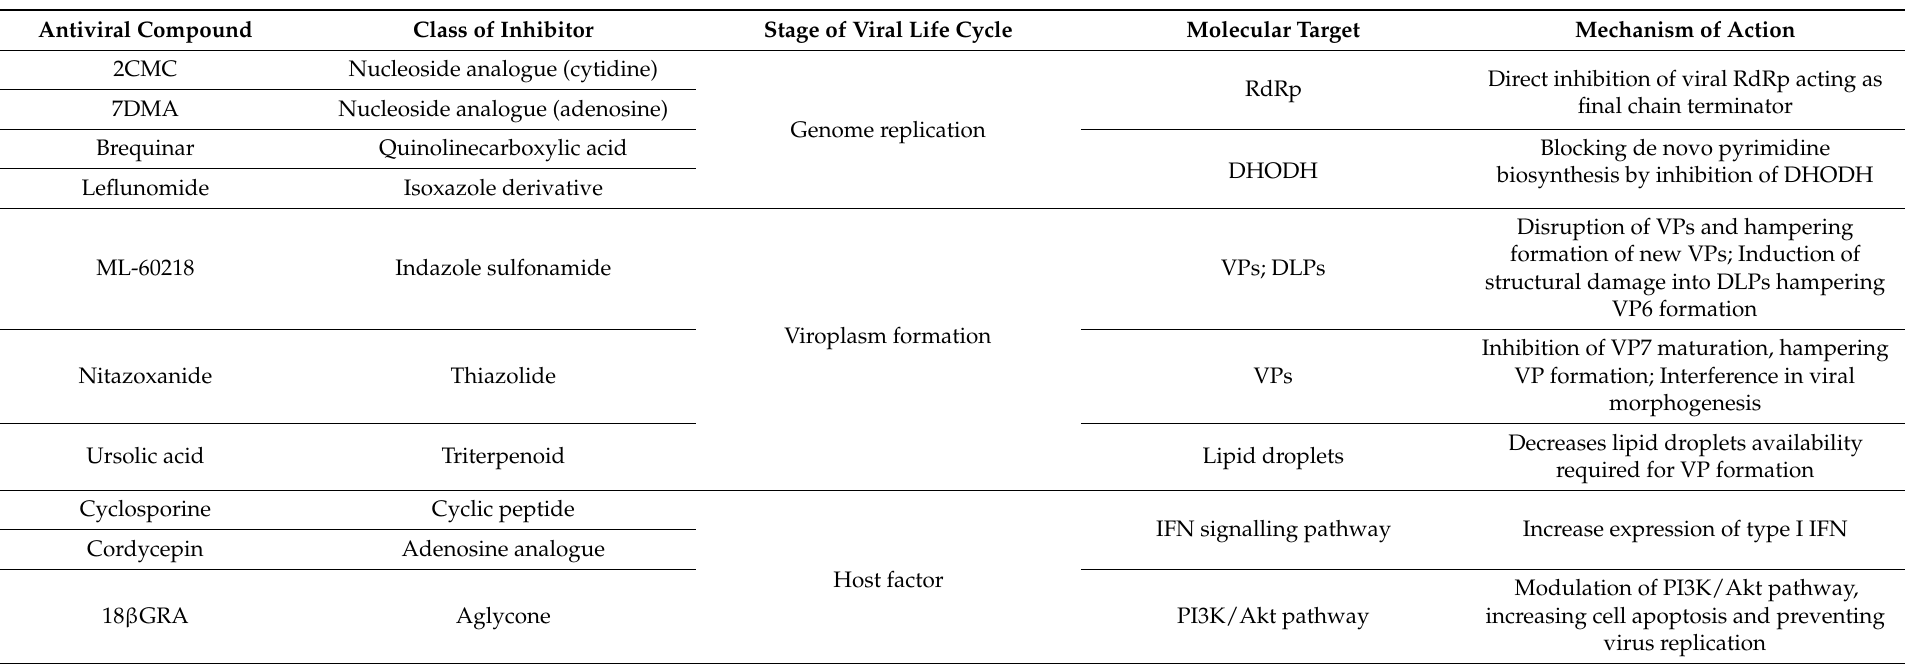
Table 1. Antiviral compounds for rotavirus infections within this